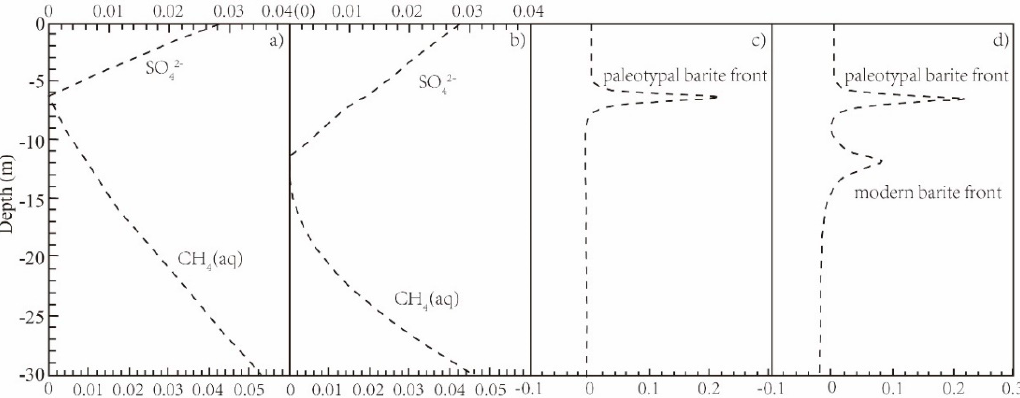
Figure 9. The results of the barite-forming process of the barite front. ( a ) Concentration of CH 4 and SO 42 − at high methane flux. ( b ) Concentration of CH 4 and SO 42 − at low methane flux. ( c ) Paleotypal barite front at high methane flux. ( d ) Modern barite front at low methane flux.